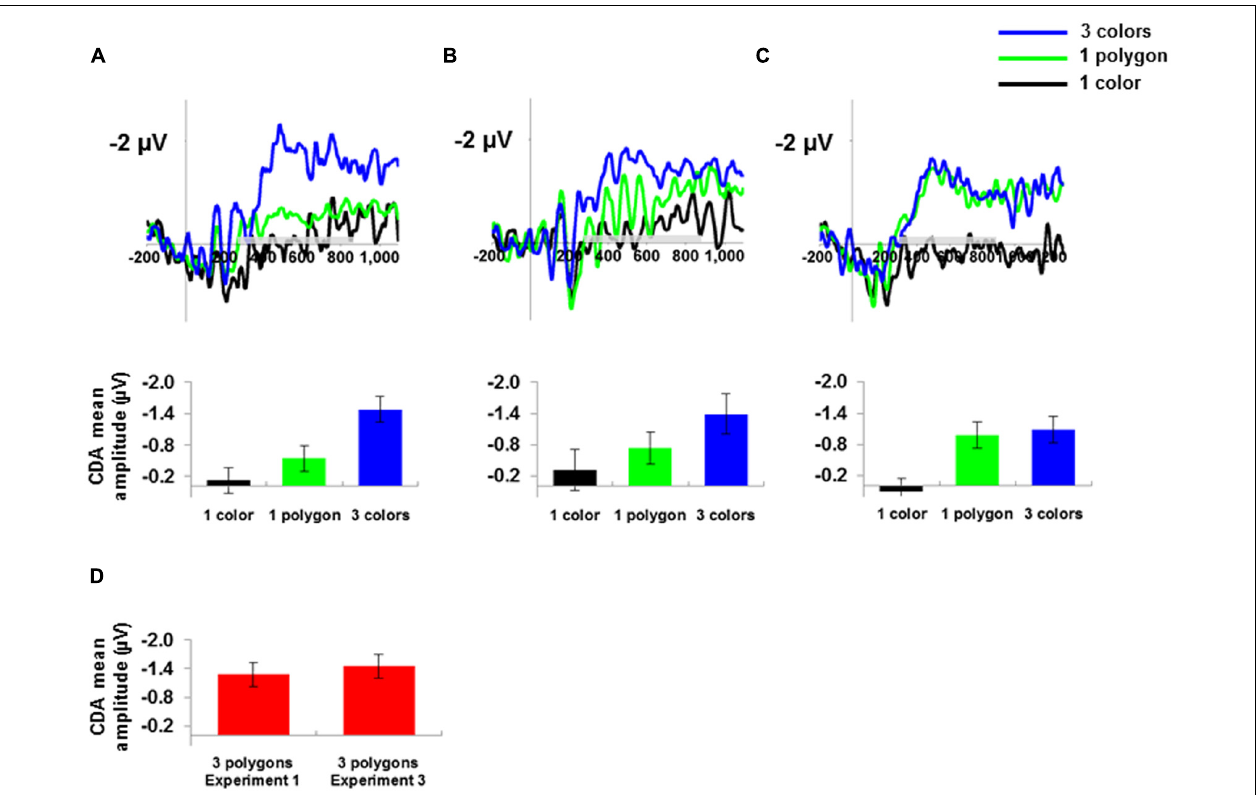
FIGURE 3 |The CDA wave (timed locked to the memory array) and mean amplitude in μ V for one color, one polygon and three colors for (A) Experiment 1, (B) Experiment 2, and (C) Experiment 3. The gray bar above the x -axis indicates the time